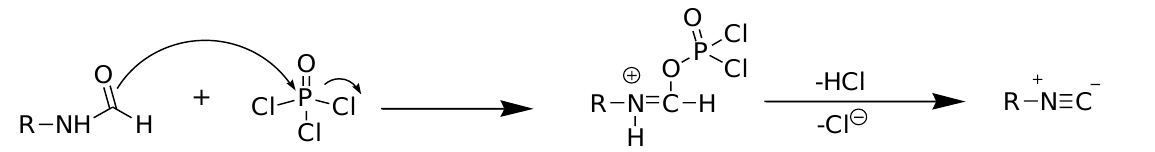
Figure 5. Mechanism of dehydration reaction using phosphorus oxychloride.